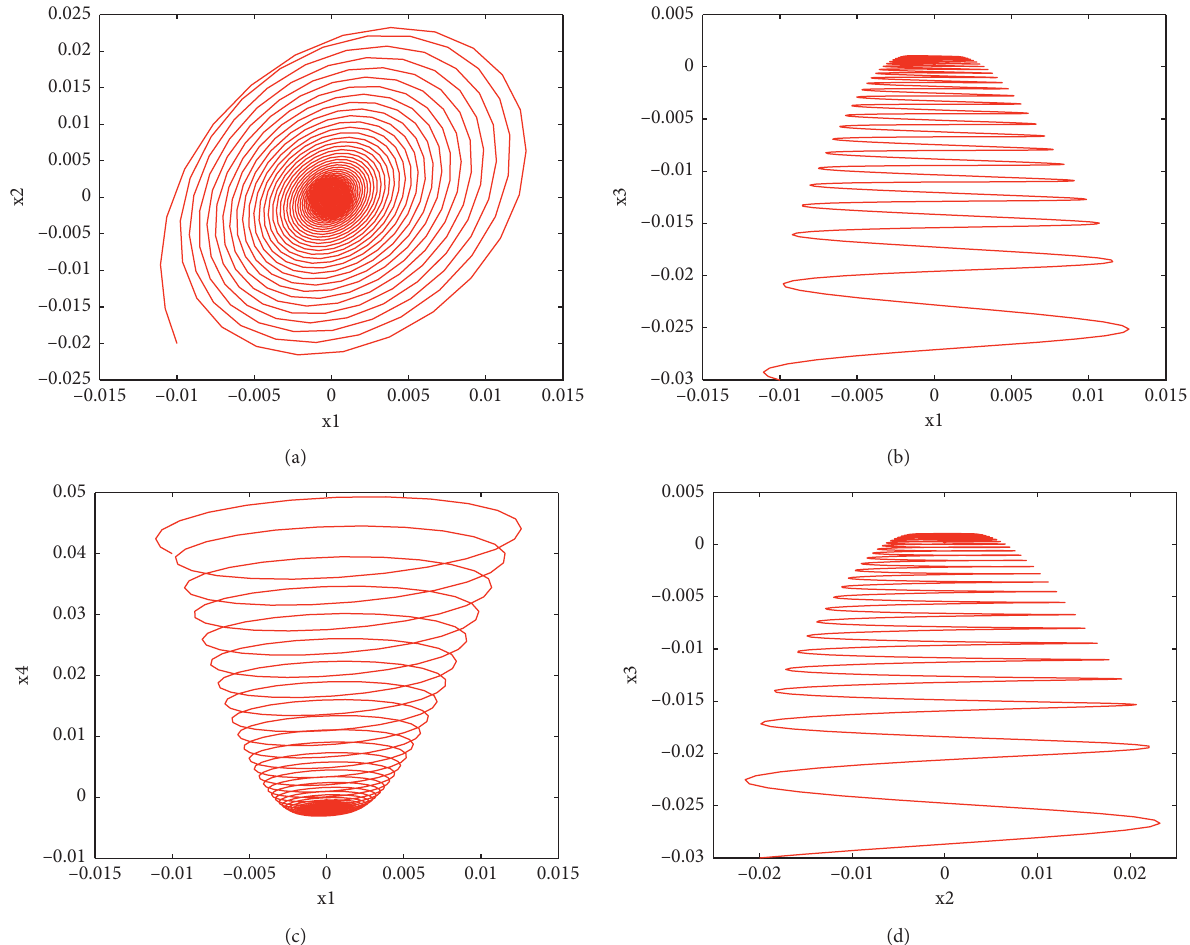
Figure 10: Attractor of the fractional-order novel hyperchaotic system with order α � 1.15 ( a � 10, b � 40, c � 2.5, and d �